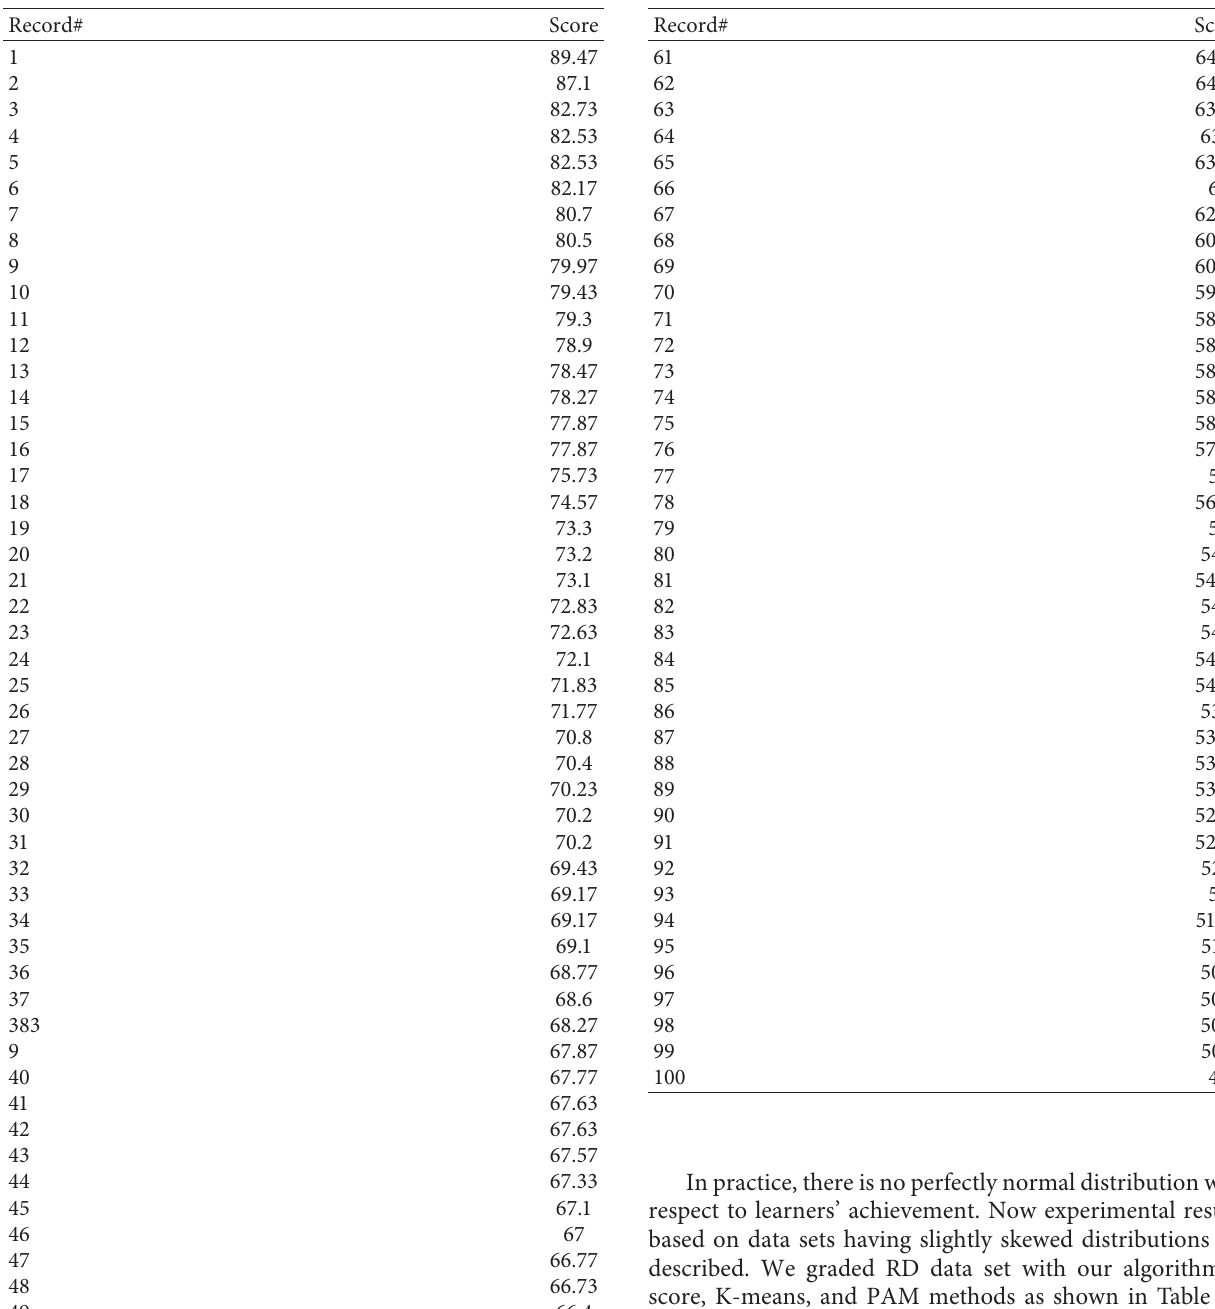
Table 5: Sorted scores of RD +data